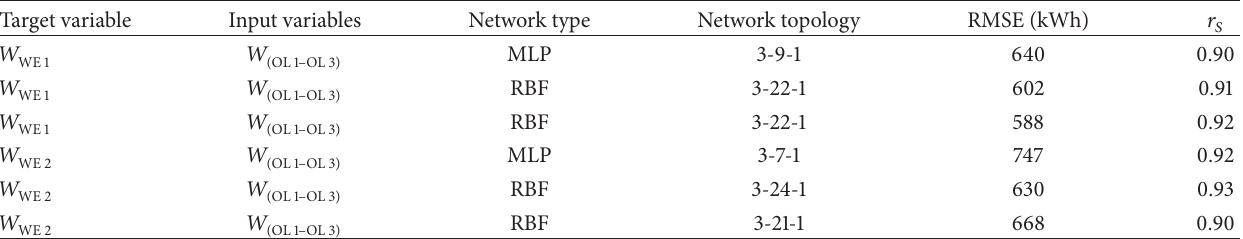
Table 13: Summary of results from the 3 best neural networks out of 20000 iteratively tested networks for the target turbines in the complex terrain of the Sauerland